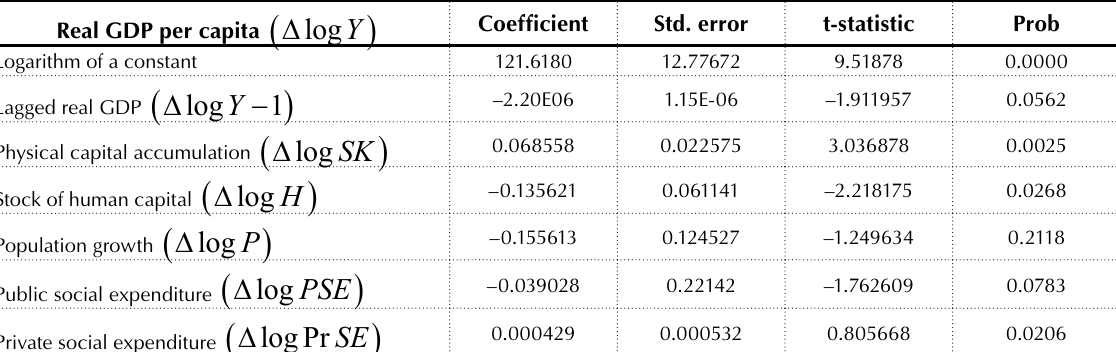
Table 6. Random Effect Regression with for the logarithm of the real GDP per capita and the logarithm of socio-economic